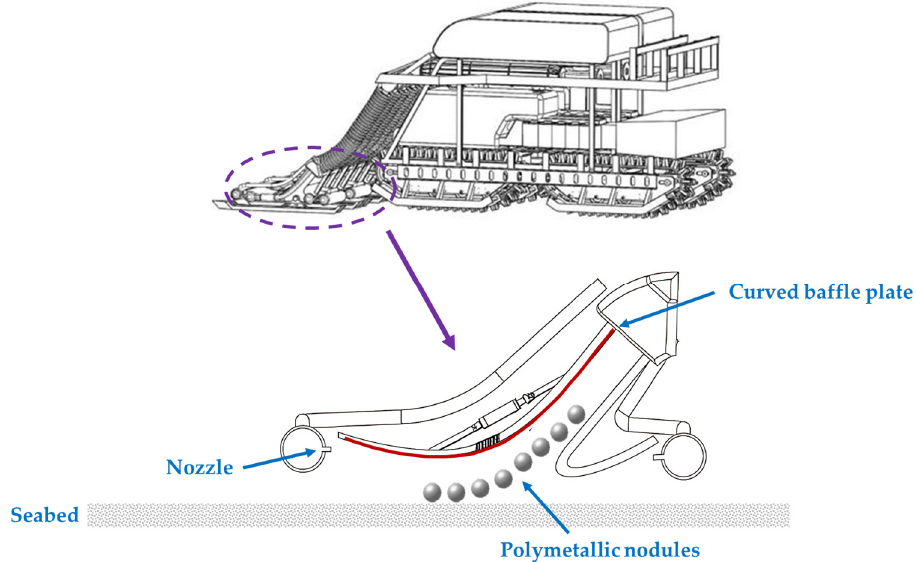
Figure 1. Schematic diagram of a Coandă effect-based hydraulic-type collector